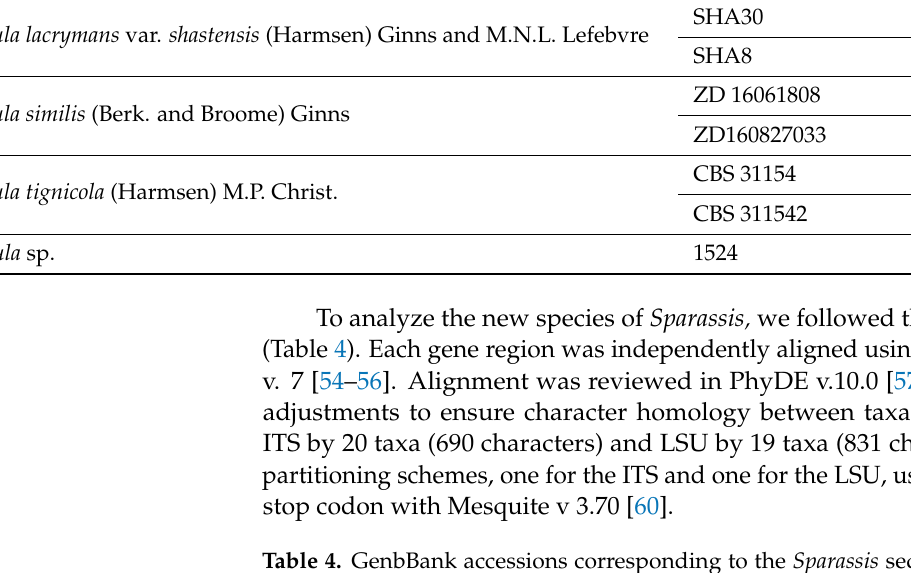
Table 4. GenbBank accessions corresponding to the Sparassis sequences used in the phylogenetic analyses. In bold, the accessions of the new